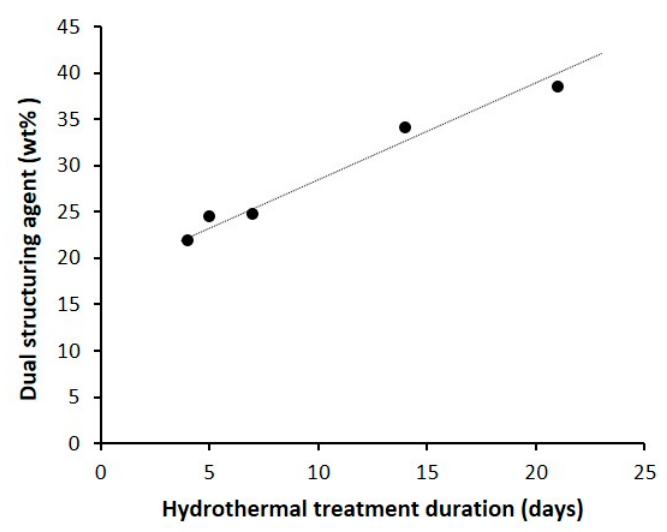
Figure 6. Evolution of the weight percentage of the dual structuring agent determined by TGA of 4-NS, 5-NS, 7-NS, 14-NS and 21-NS samples with the hydrothermal treatment duration.